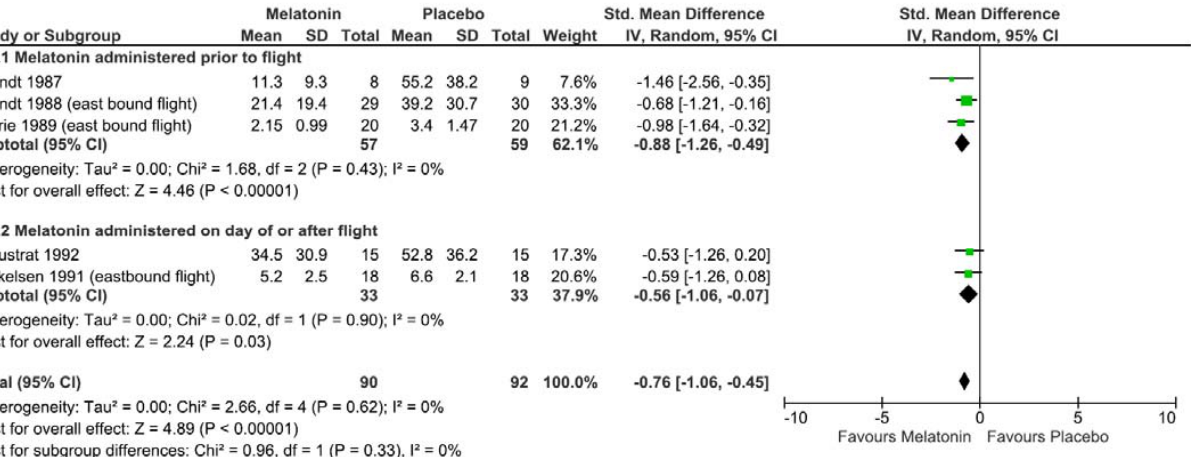
Figure 3. Forest plot of Cohen d effect size (standard mean difference) of studies examining the effect of melatonin on participant self-reported jetlag symptoms following eastbound commercial air flights using a random effects model. Studies grouped by melatonin administration time of either prior to departure or at bedtime on the day of flight or after arrival. Diamond represents overall effect size, squares indicate percentage weighting of each study to overall effect size and 95% confidence intervals shown using horizontal lines.